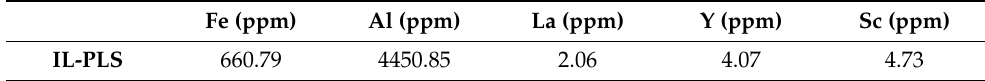
Table 1. Metal content concentration in the prepared